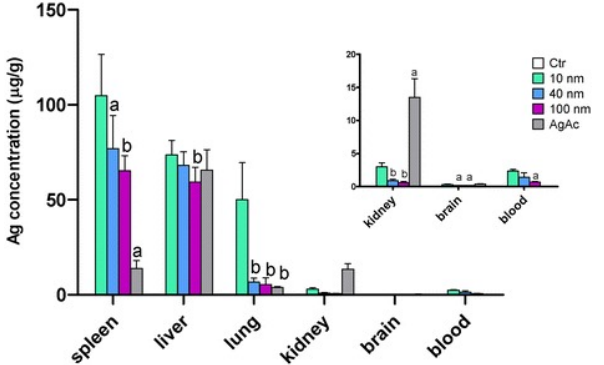
Figure 27. Silver tissue concentration after i.v. injection of AgNPs and AgAc in mice. Data are expressed as means ± SD. The inset illustrates a magnified view showing Ag concentration in the kidney, brain, and blood. Statistical significance: a = p < 0.05; b = p < 0.01. Reproduced from [229], BioMed Central Ltd under the Creative Commons Attribution